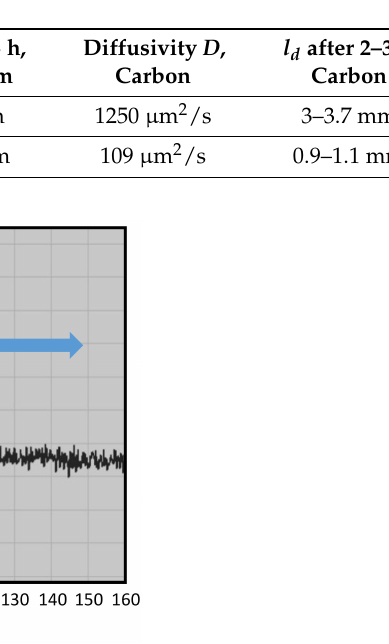
Figure 35. EDX scan through the weld interface, starting from the ODS steel region in the vicinity of channel A (see in Figure 33). The Cr concentration drops from about 14 at. % to about 10 at. % within a diffusion length of approximately 25–30 µ m. The extension of the previously observed weld interface zone (WIZ) is clearly higher than that. Note: The atomic percentage of the Cr content in the ODS steel amounts to about 14. If the value of 85 on then y -axis is correlated to 14, then the value of 63 corresponds to 10 at. %, which is the Cr content in